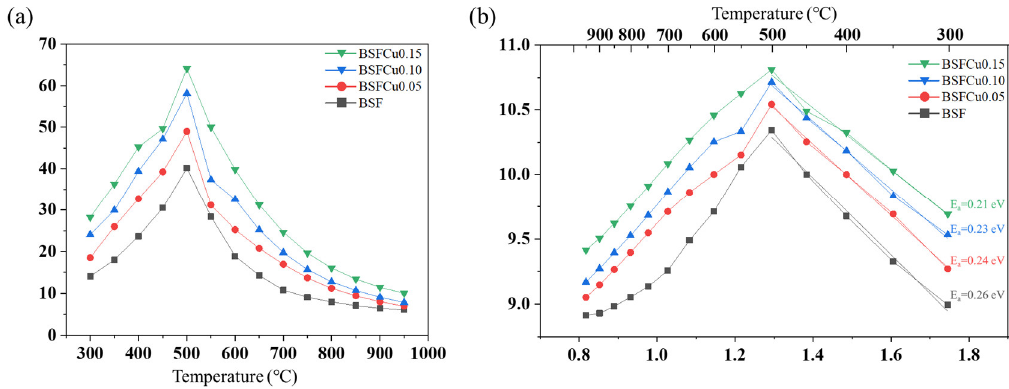
Figure 6. ( a ) The temperature dependence of electrical conductivity of the Ba 0 . 5 Sr 0 . 5 Fe 1-x Cu x O 3−δ (x = 0, 0.05, 0.10, 0.15) measured from 300 °C to 950 °C in air; ( b ) ln(σT) vs. 1000/T plot. The cross-section view of the BSFCu0.15|SDC|BSFCu0.15 symmetrical cell